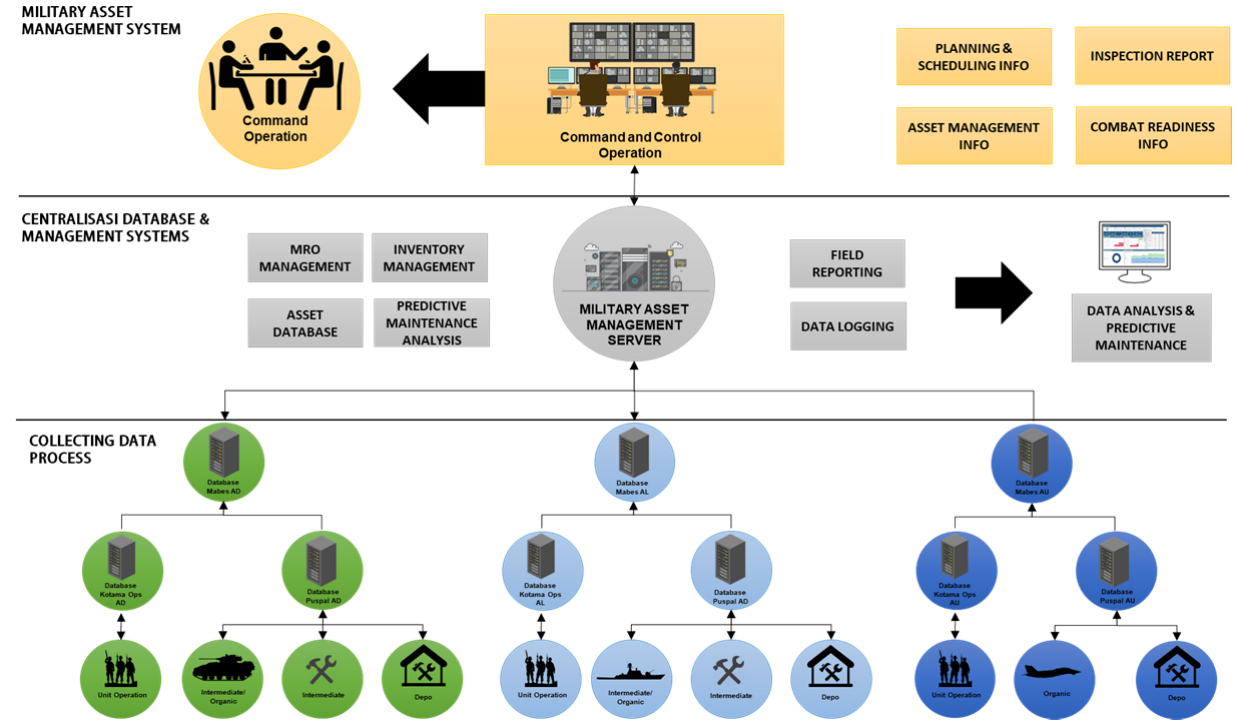
Figure 2. Concept Military Asset Management